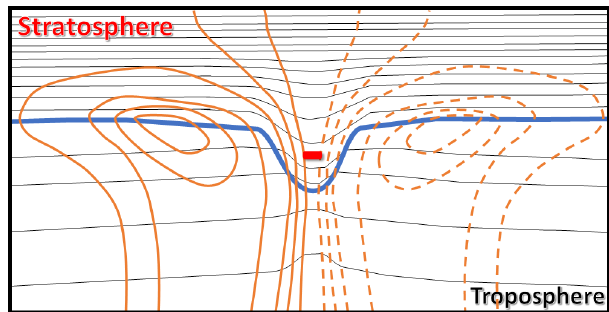
Figure 1. Conceptual model of a cross-section through a high- PV anomaly (negative sign in red) in the Southern Hemisphere (adapted from Lackmann, 2011). Black lines represent isentropes, whilst orange lines represent meridional wind velocities (dotted negative, solid positive). The bold blue line represents the dynami- cal tropopause (a constant PV